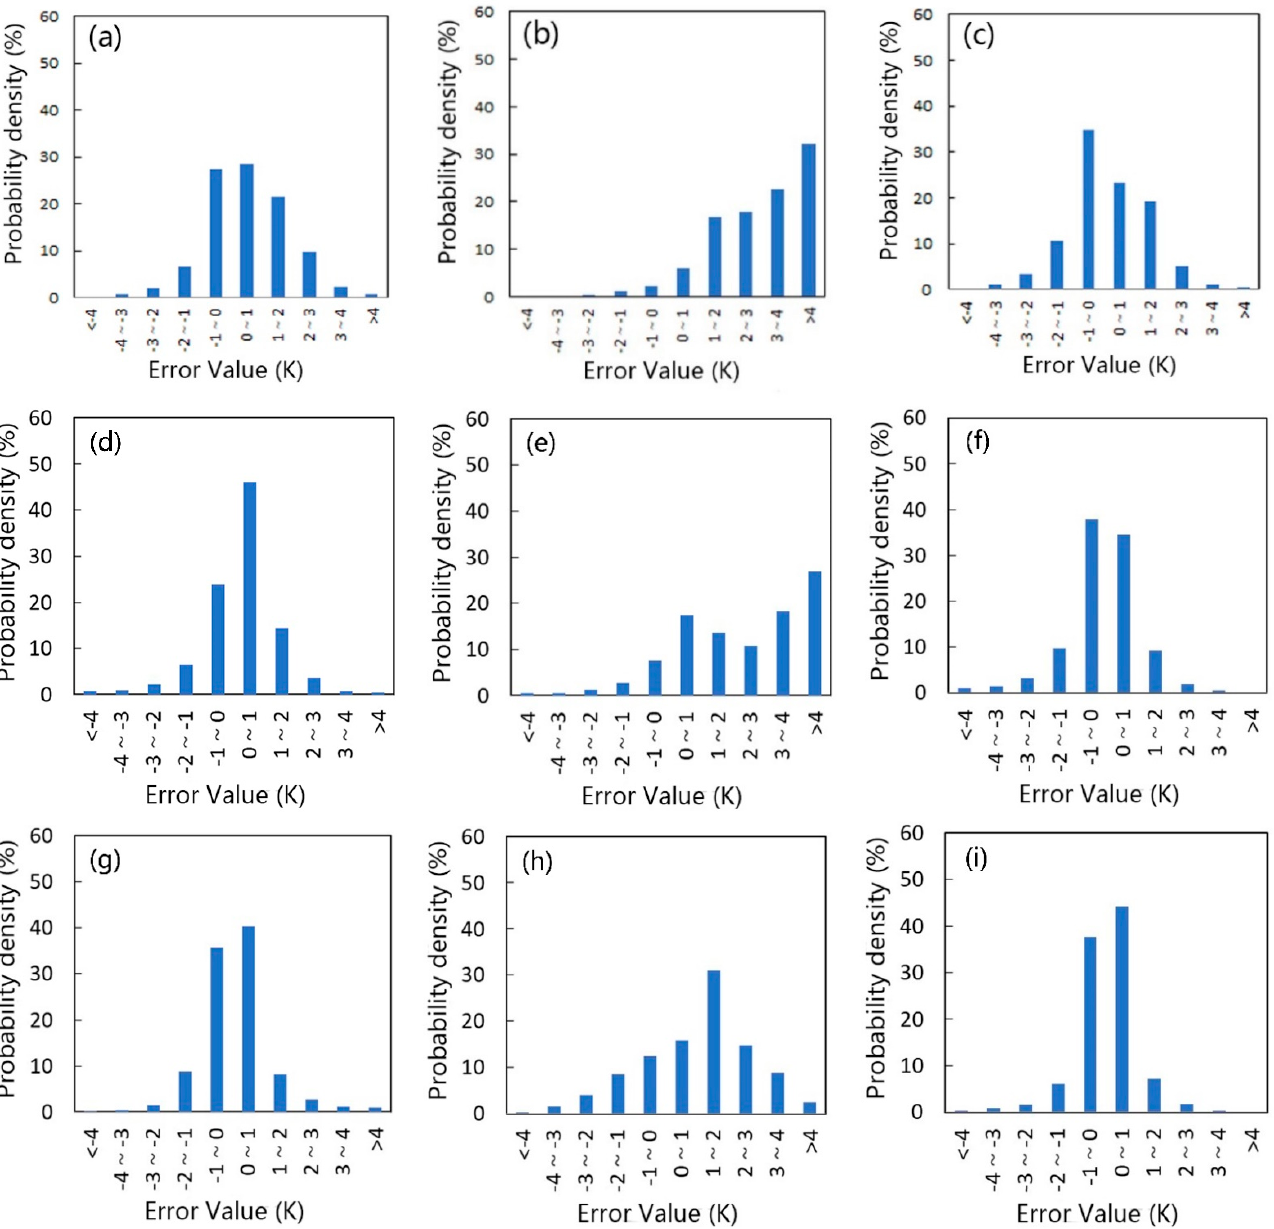
Figure 10. Differences probability (with respect to Landsat-8- and GF-6-retrieved LST) in downscaled results obtained using three different downscaling methods and different GF-6 bands on 26 August 2019 ( a ) DisTrad LST GF 6_ Nir , ( b ) DisTrad LST RE 1 , ( c ) DisTrad LST RE 2 , ( d ) TsHARP LST GF 6_ Nir , ( e ) TsHARP LST RE 1 , ( f ) TsHARP LST RE 2 , ( g ) MIRF LST GF 6_ Nir , ( h ) MIRF LST RE 1 , ( i ) MIRF LST RE 2 Table 4. The statistics for the three groups.